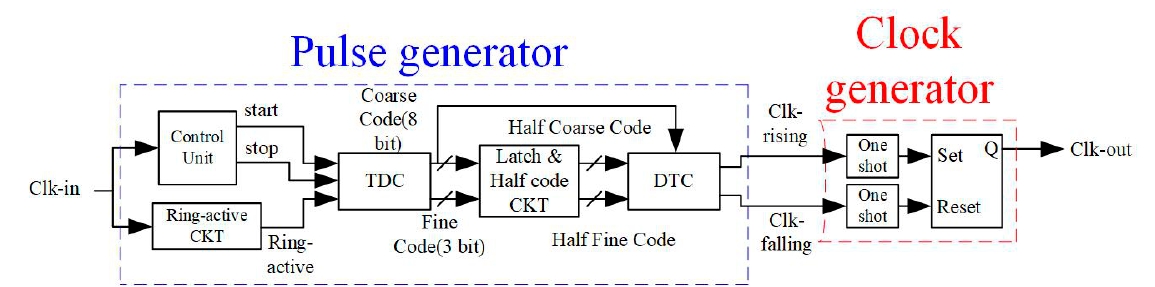
Figure 1. Architecture diagram of the proposed ADDCC. (CKT: Circuit)